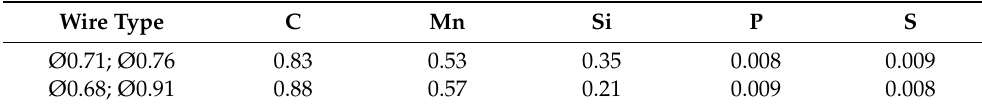
Table 1. Chemical analysis of the wire steel (wt.%).